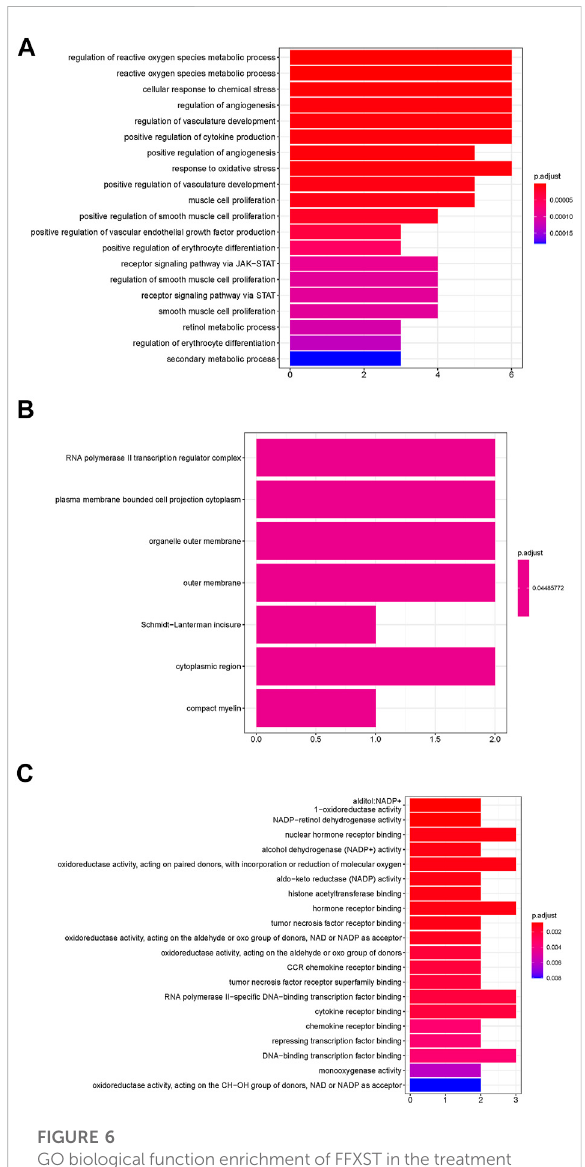
FIGURE 6 GO biological function enrichment of FFXST in the treatment of IS. (A) BP categories, (B) CC categories, and (C) MF